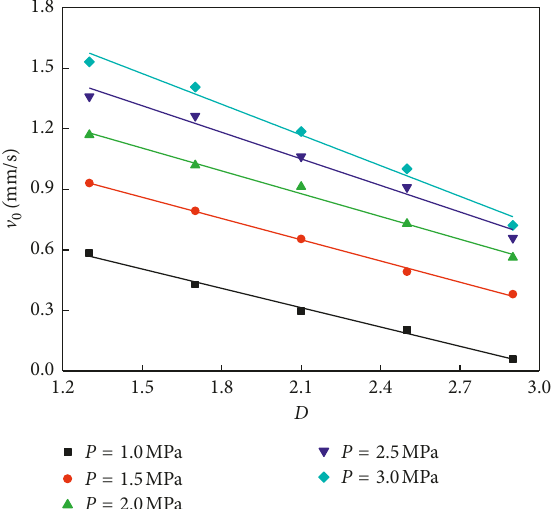
Figure 10: The variation curve of seepage velocity with the vari- ation of seepage pressure in different fractal dimensions.